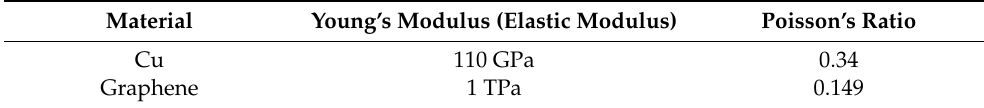
Table 1. Properties of Cu and graphene in the RVE model.